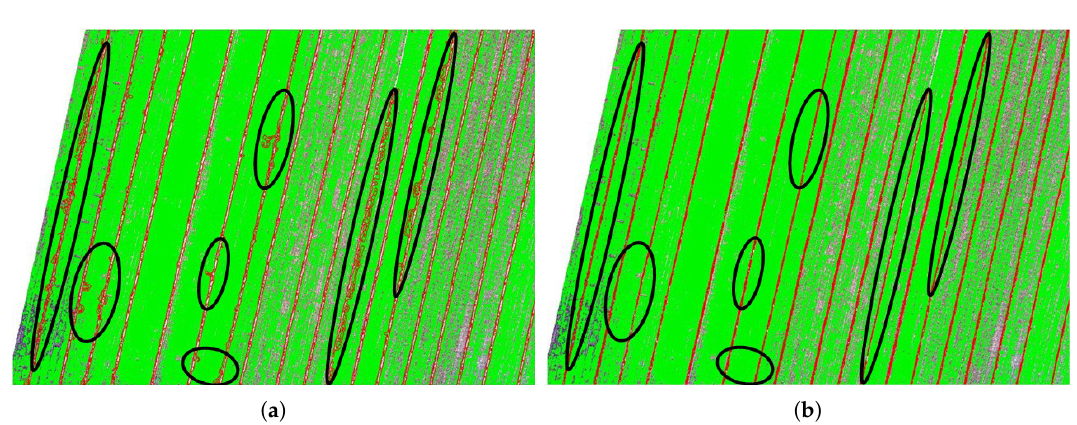
Figure 10. Ridge extraction before ( a ) and after ( b ) removing vegetation impacts in partial Plot 1. Overlaying images are the ridge candidates (red lines) and vegetation coverage (green). Significantly improved ridges are marked with black